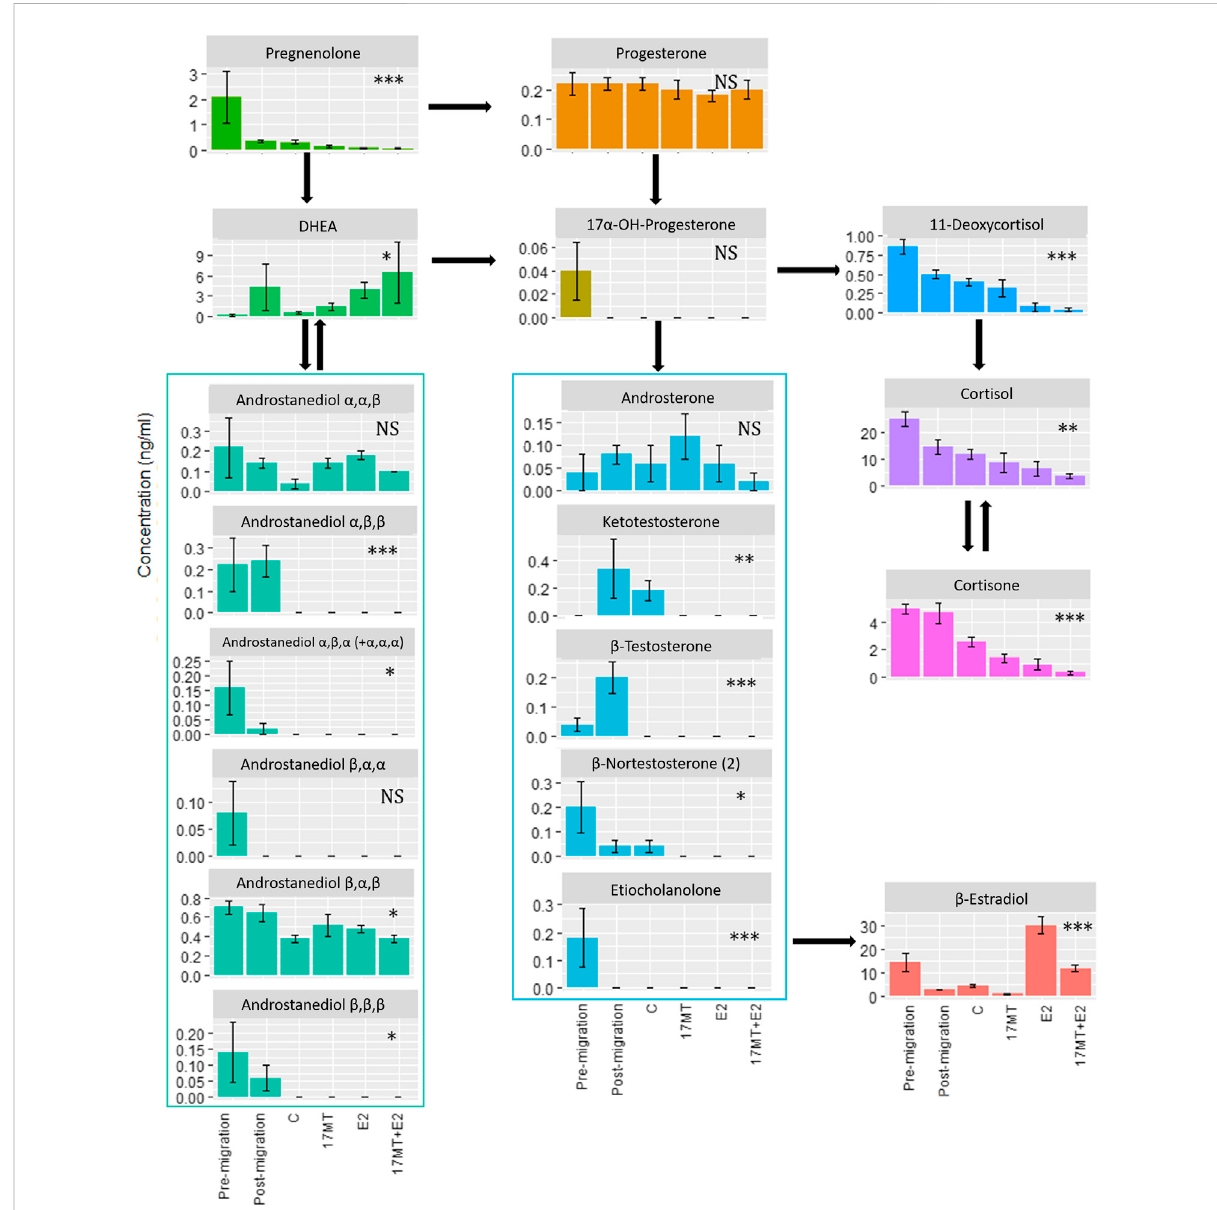
FIGURE 4 Blood plasma concentrations of steroids as determined by LCMS. Twenty out of thirty-three steroids showed detectable levels of which fi fteen showed signi fi cant differences between treatment groups: pre-( N = 5) and post-simulated migration ( N = 5); control (C group; N = 5); 17 α